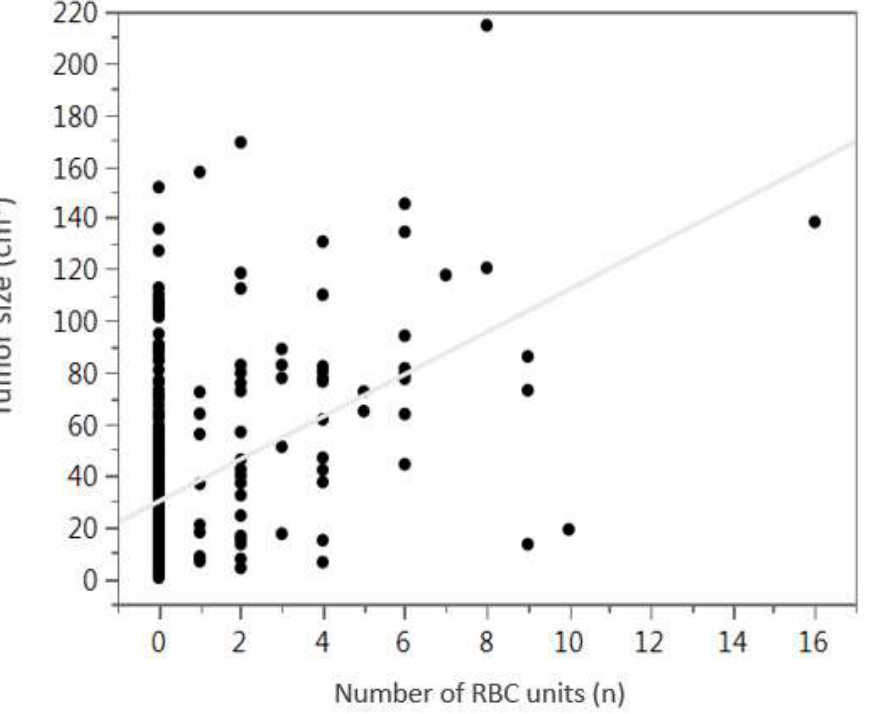
Figure 2. Simple linear regression illustrates the significant correlation of tumor size and number of transfused RBC units (R 2 = 0.0183; p < 0.0001); RBC, red blood cell. 3.5. Survival Kaplan-Meier curves revealed significant influence on overall survival by RBC trans- fusion, preoperative anaemia, smoking, cardiovascular disease, preoperative KPS ≤ 60% and age (elderly patients ≥ 75 years). No influence was observed for diabetes and WHO grade (Figure